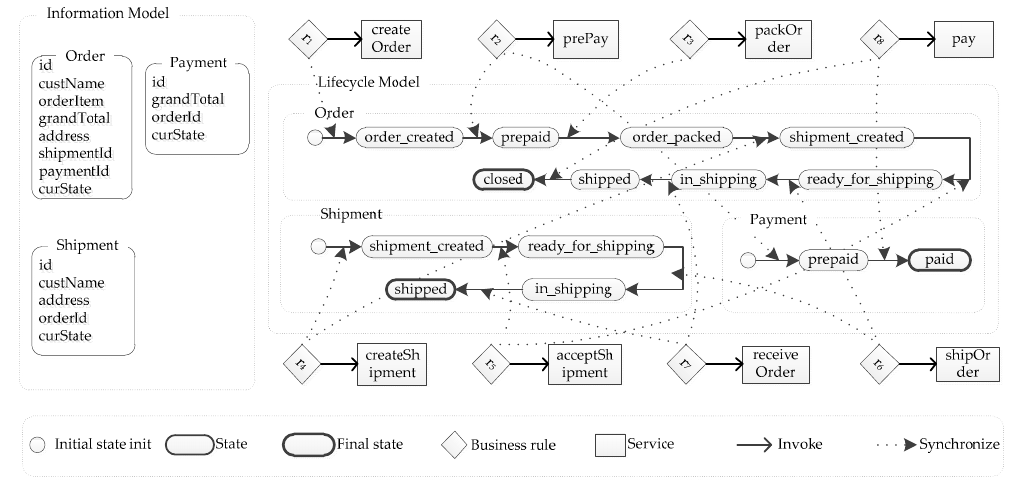
Figure 1. Artifact-centric representation of a purchase business process.